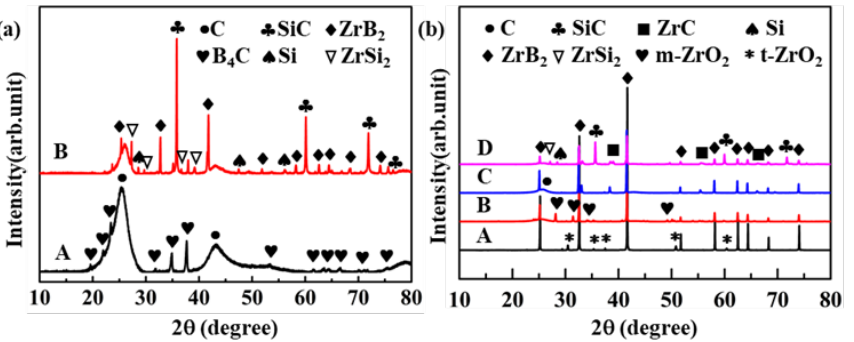
Figure 5. XRD patterns of different preforms and composites: ( a ) A, C/C–B 4 C preform; B, B 4 C-composite; ( b ) A, initial ZrB 2 particles; B, C/C–ZrB 2 preform after pyrolysis at 1000 °C; C, C/C–ZrB 2 preform after heat treating at 1600 °C; D, ZrB 2 -composite.